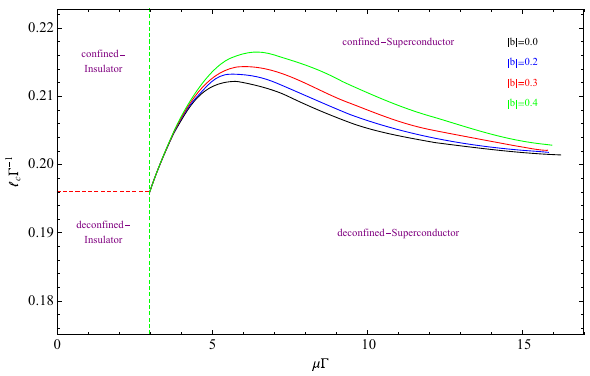
Fig. 6 The phase diagram of the entanglement entropy for a strap geometry in the holographic insulator/superconductor transition with ENE field. The black curve is for | b | = 0 and the blue curve is for | b | = 0 . 2. The red curve is for | b | = 0 . 3 and the green curve is for | b | = 0 . 4